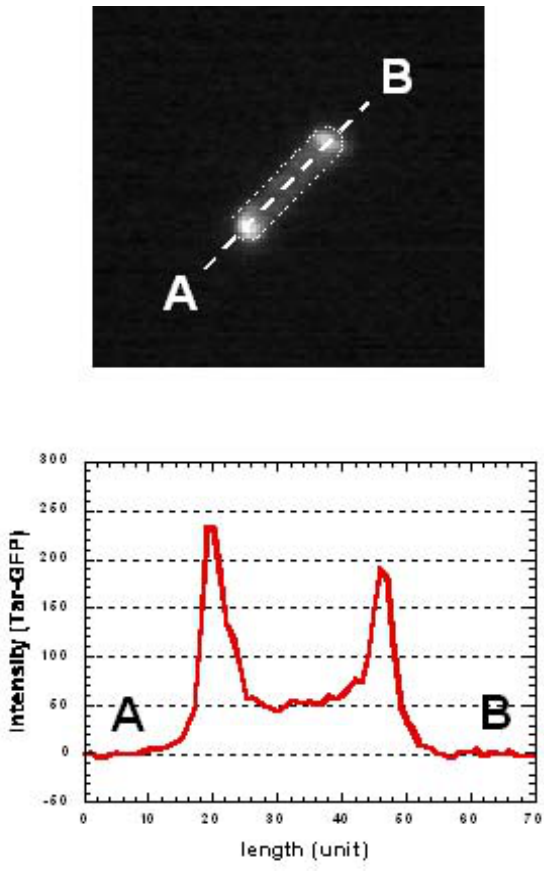
Figure 14. Tar-GFP localization in E. coli cell. Upper fluorescence image shows the localization of GFP-tar proteins at the both poles in a E. coli . Lower graph shows the histogram of GFP localization profile from point A to B (see upper image) indicating fluorescence localized at